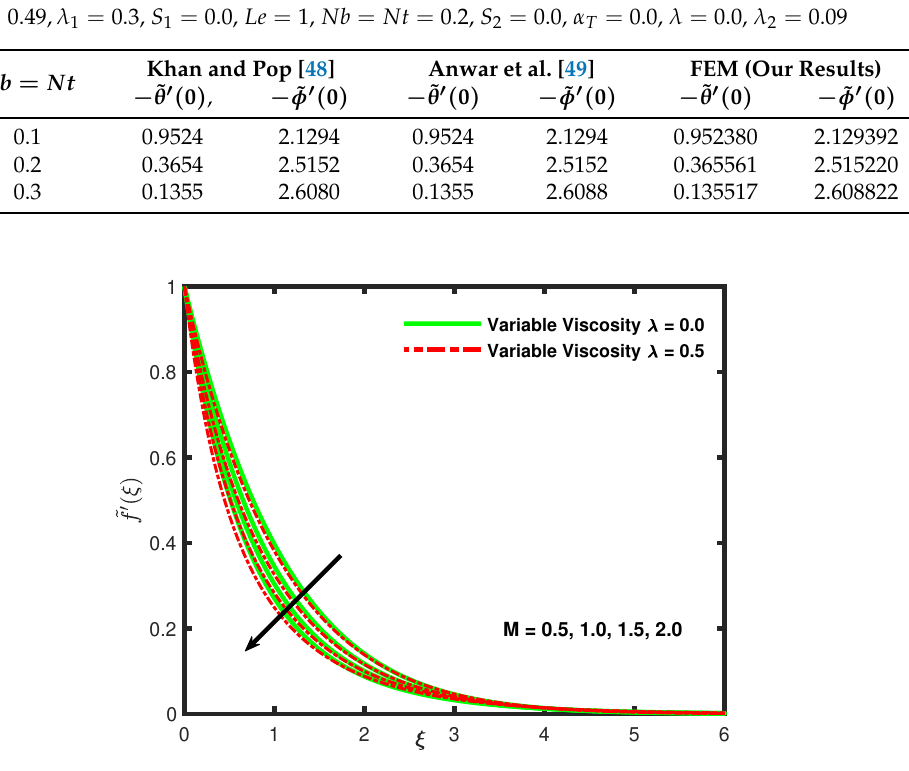
Table 5. Comparison of − ˜ θ (cid:48) ( 0 ) , and − ˜ φ (cid:48) ( 0 ) for different values of Nb and Nt when Pr = 1,